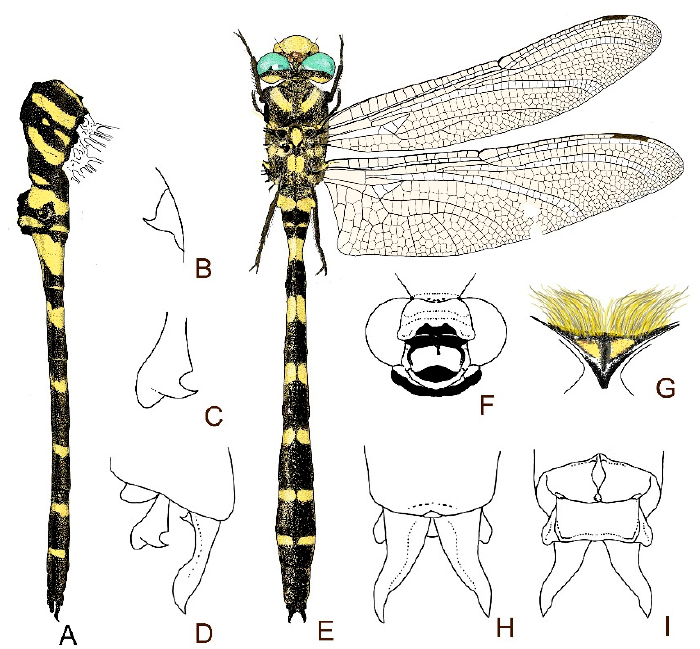
Figure 9. Cordulegaster kalkmani sp. nov., holotype ♂ (RMNH, leg. Gert Jan van Pelt, RMNH.INS.974903, 23.07.2007, Turkey, Kars, 16 km NE Sarikamis: 40.4203° N 42.7446° E, 1800 m a.s.l.): ( A ): habitus, lateral. ( B ): medioventral tooth, lateral. ( C ): hook, lateral. ( D ): appendages, lateral. ( E ): habitus, dorsal. ( F ): head, schematically. ( G ): occipital triangle, frontal. ( H ): appendages, dorsal. ( I ): appendages, ventral. Thorax (Figure 9A,E): anterior lobe with yellow frontal edge, median lobe of prono- tum black, posterior lobe with yellow margin at the rear edge that narrows dorsolaterally; front of synthorax with broad yellow antehumeral stripes, narrowing towards pronotum leaving less than 30% black of the antehumeral region; small yellow dot on the mesanepis- ternum near the antealar ridge; mesepimeron and metepimeron with broad yellow bands; metepisternum black with yellow interrupted stripe-like marking reaching to one third of basal margin; metakatepisternum black; poststernum black; coxae black with yellow parts, trochanter, femora, tibiae and tarsi black. Wing (Figure 9E hyaline; Pt black; FW 3.8 × 0.5; HW 4.5 × 0.7; anal triangle with 3 cells; all veins black, except costa. Abdomen (Figure 9A,E): color pattern as in Figure 9A; S1 black with two yellow markings in lateral view, S1 dorsally covered with yellow hairs, yellow marking (abdominal rings) on side of S1 semilunar; S2 to S8: yellow abdominal rings of S2 and S3 dorsally connected, rings of S4 to S8 interrupted by fine black line, yellow abdominal rings leaving a bigger part black but running onto underside; S9–S10 black. Appendages (Figure 9B–D,H,I): superior appendages in dorsal view slender and diverging, with pointed and slightly curved tips, nearly as long as S10; laterobasal tooth not visible in lateral view because it is covered by the rear edge of S10, prominent medioventral tooth, with a claw-shape tip only visible in lateral view, located at the base of the inferior near S10 (Figure 8B,D); inferior appendage in lateral view at the end with a single pointed hook-shaped tooth on each side (Figure 9C,D). Inferior appendage broad, nearly parallel- sided, the dorsally pointing lobes widen the inferior distally, hind margin not notched (Figure 9I). Measurements (in mm) : TL (inclusive appendages) 74.0, AL 58.0, HWL 46.0, FWL 46.0. Description of female paratype. Head (Figure 10A): much as in , additional small black line at crest of ♂